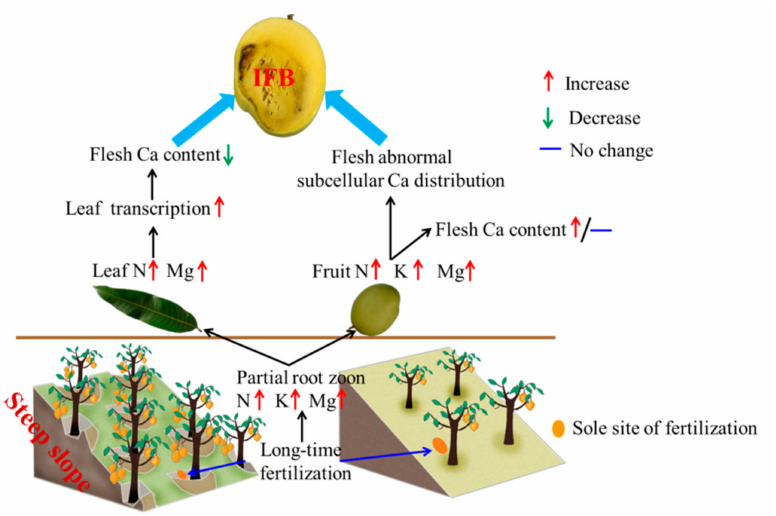
Figure 14. Speculative scheme of internal flesh breakdown development in mango fruit grown on the steep slope of a